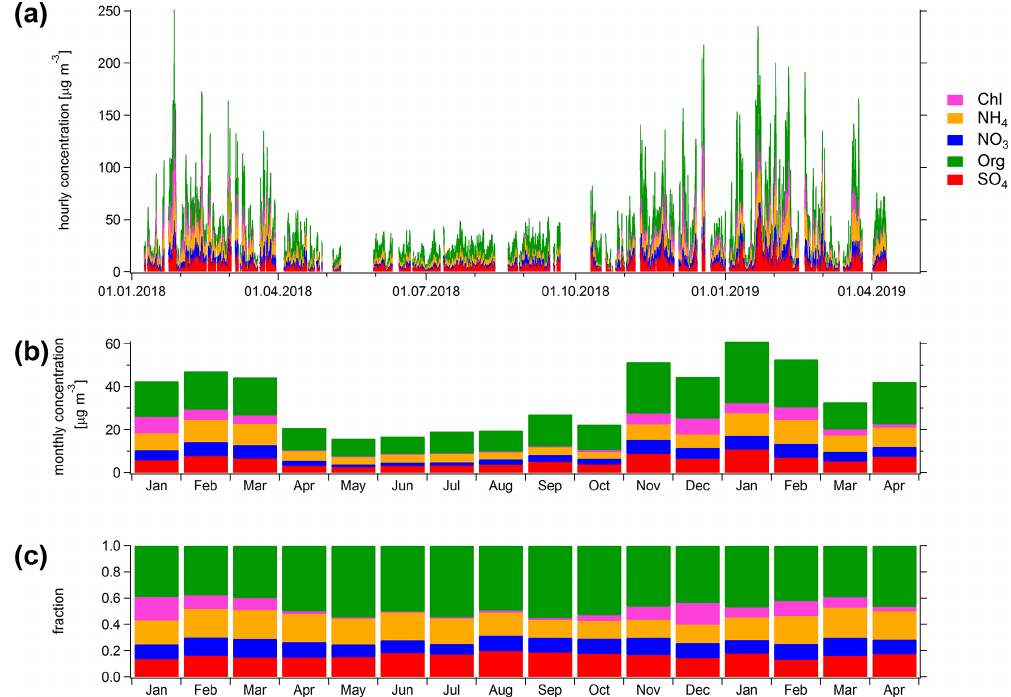
Figure 1. (a) Hourly chemical composition of NR PM 1 in Kraków from 8 January 2018 to 10 April 2019. The bar plots show the monthly average chemical composition in (b) absolute mass loadings and (c) relative fractions. All times are in UTC.